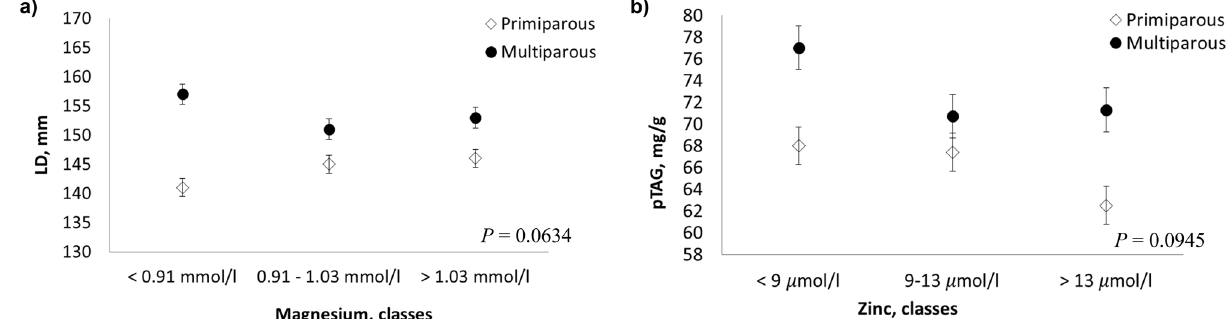
Figure 6. Least squares means (LSM) for predicted liver triacylglycerol (pTAG), and liver depth (LD) across the classes of hematic minerals. ( a ) magnesium; ( b ) zinc. Black dots/rhombus indicate the LSM and error bars indicate the standard